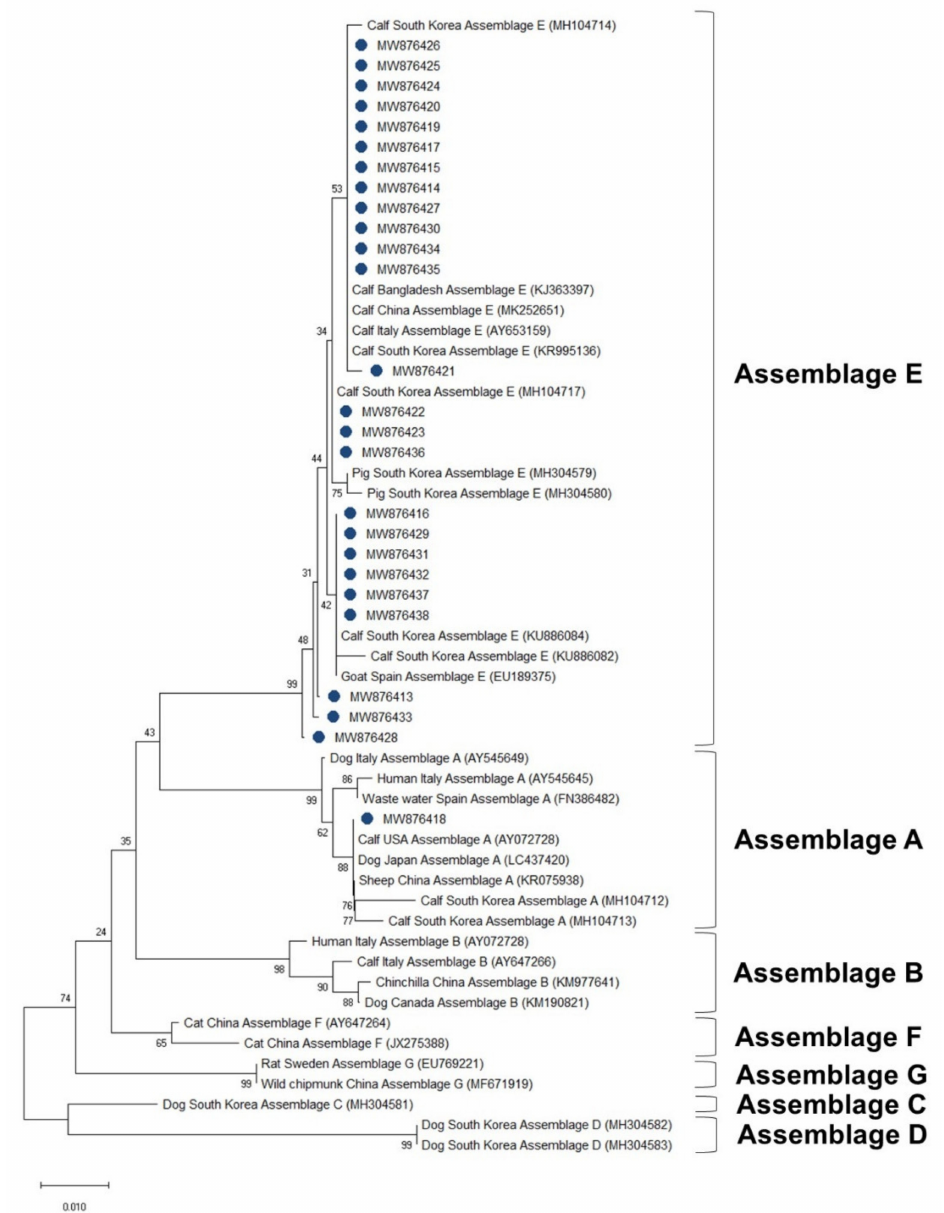
Figure 4. Phylogenetic tree of G. duodenalis based on β -giardin gene sequences. The neighbor-joining method was used to construct the tree; the blue circles indicate the sequences detected in this study. The GenBank accession numbers are shown in parentheses, and the G. duodenalis assemblages are indicated with one-sided square brackets. Tree reliability was tested by running 1000 bootstrap